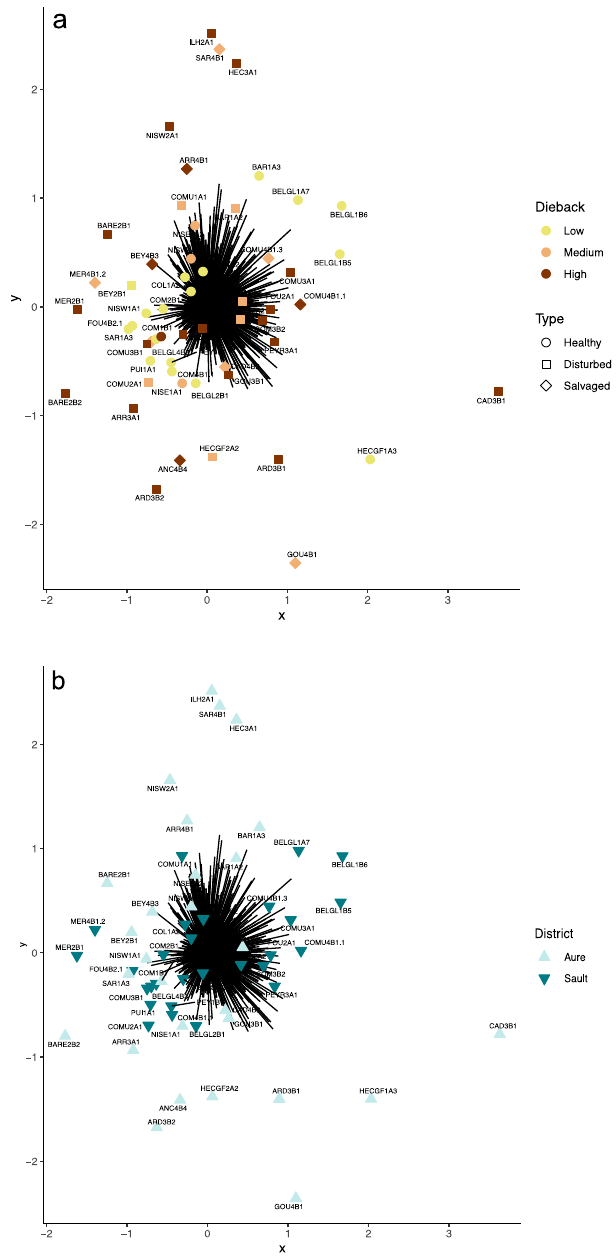
Fig. 5 Variation in community composition across dieback gradient, stand types and geographical districts. Gaussian copula ordination plots representing variations in insect community assemblages in regards to: a dieback level conditions (i.e. low, medium and high) and stand types (i.e. healthy, disturbed and salvaged), and b to the two different geographical districts sampled. Mvabund analyses of community dissimilarities were performed using 999 bootstraps. Each black line represents the resultant of both factors 1 and 2 of the traitGLM Gaussian copula ordination for each studied plot reduced to 95% of the 2.5 set alpha-ratio. Ordination a highlighted higher similarity in community composition between low dieback level plots than the other two dieback levels, more similar to each other but expressing high variability in community composition. No grouping of salvaged-logged plots in terms of community composition could be distinguished. Ordination b highlighted the greater dissimilarity in terms of community composition within plots of Aure valley compared with Sault plateau that hosted species assemblages more similar to each